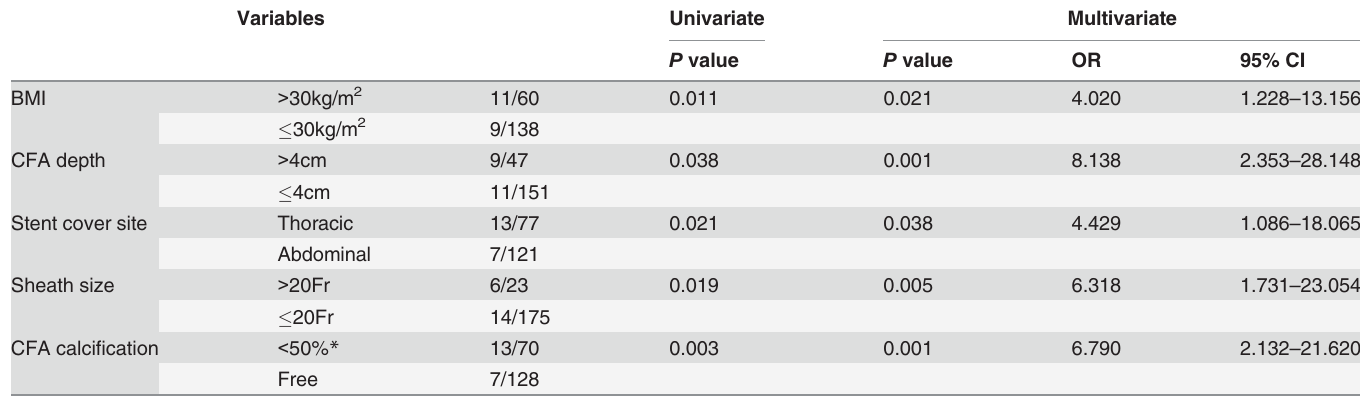
Table 4. Logistic regression analysis of preoperative classified variables for PRC.